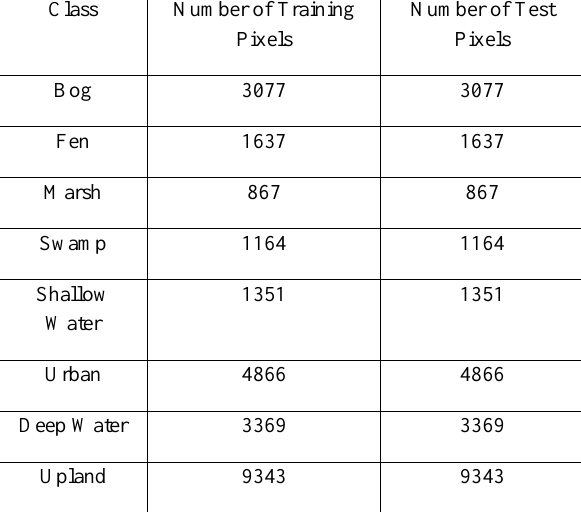
Table 2. Training and test pixel sample for the pilot site of the